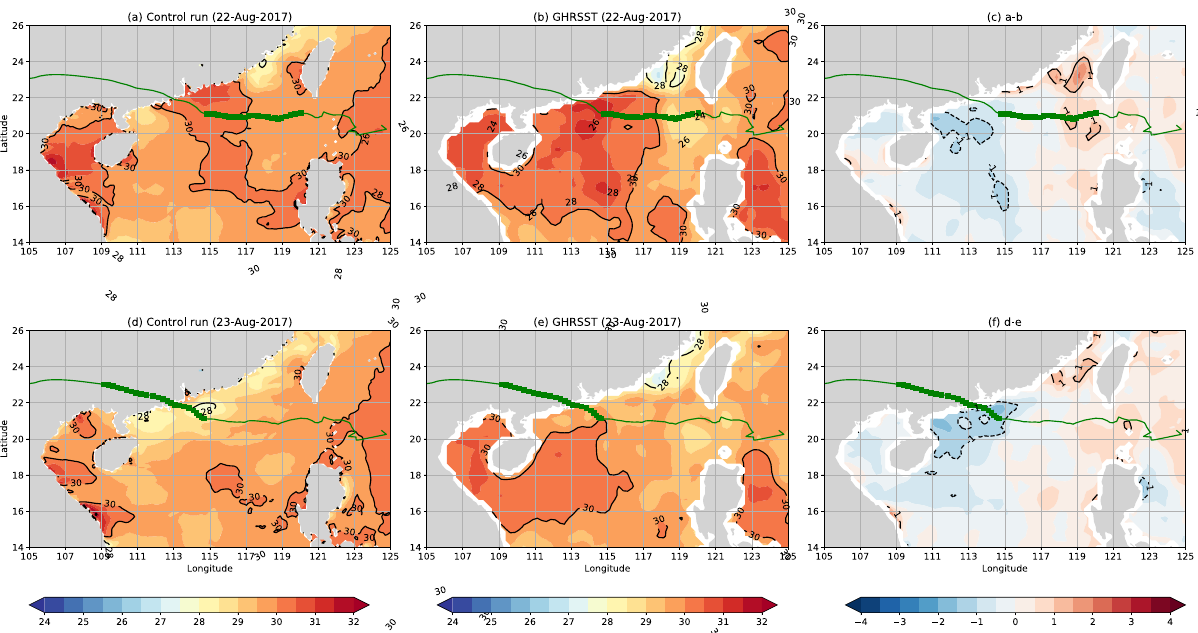
Fig. 10 Comparison of simulated SST and GHRSST. Daily mean SST in °C from a , d the control experiment and b , e the GHRSST-ABOM dataset. c , f SST differences in °C between the model and the GHRSST dataset. a – c and d – f are dated on 22 and 23 August 2017 respectively. Green lines are the track of Typhoon Hato, highlighted with squares on the corresponding